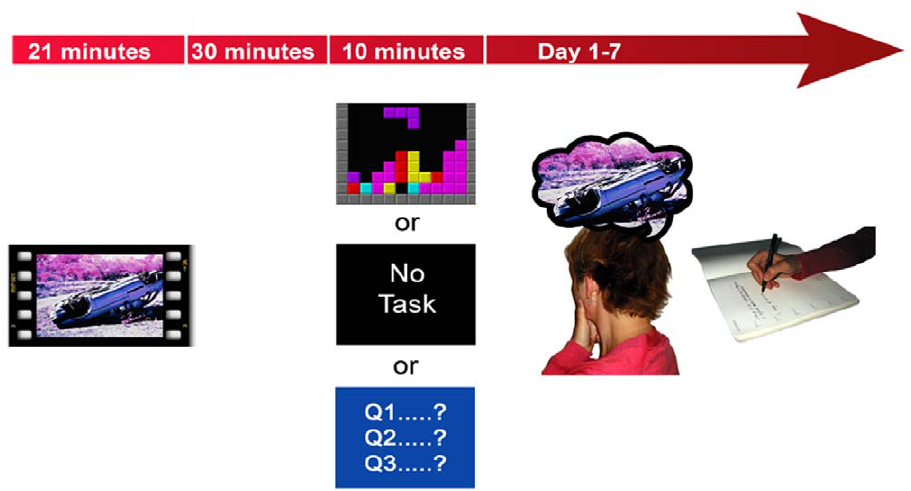
Figure 1. Experiment 1 study design overview. Participants completed the trauma film paradigm, a well established experimental analog for PTSD. All participants viewed a traumatic film followed by a 30-min structured break. Participants were then allocated to one of three experimental conditions [Tetris vs. no-task control vs. Pub Quiz] which they completed for 10 min. Afterwards participants in the computer game conditions rated their enjoyment of the game. Flashbacks (involuntary memories) were monitored for 1 week using an intrusion diary. After 1 week, diary compliance was checked and a test of voluntary memory (recognition memory test) for the trauma film was administered.